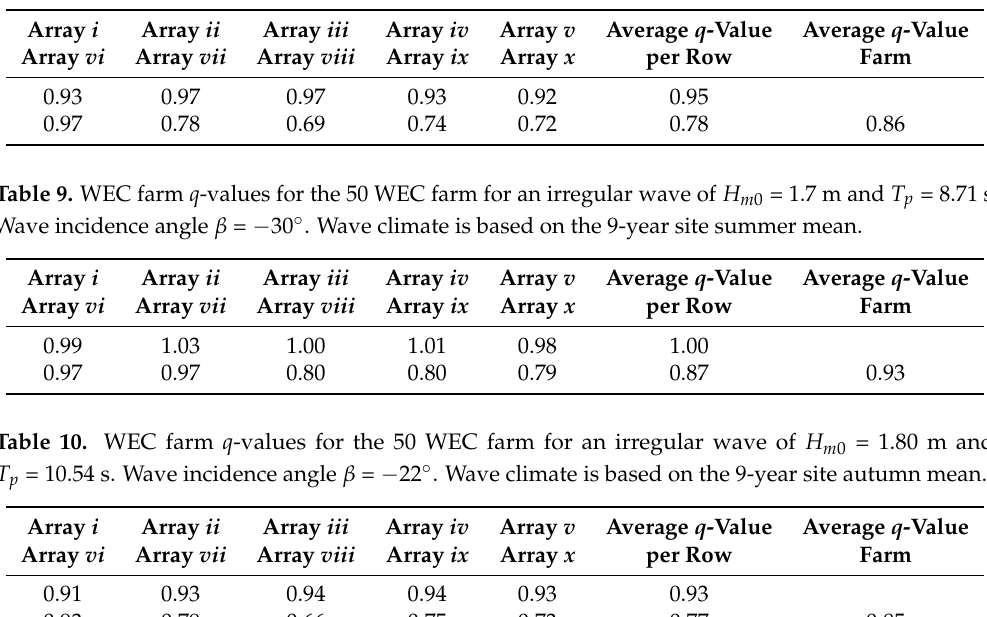
Table 8. WEC farm q -values for the 50 WEC farm for an irregular wave of H m 0 = 2.55 m and T p = 11.71 s.